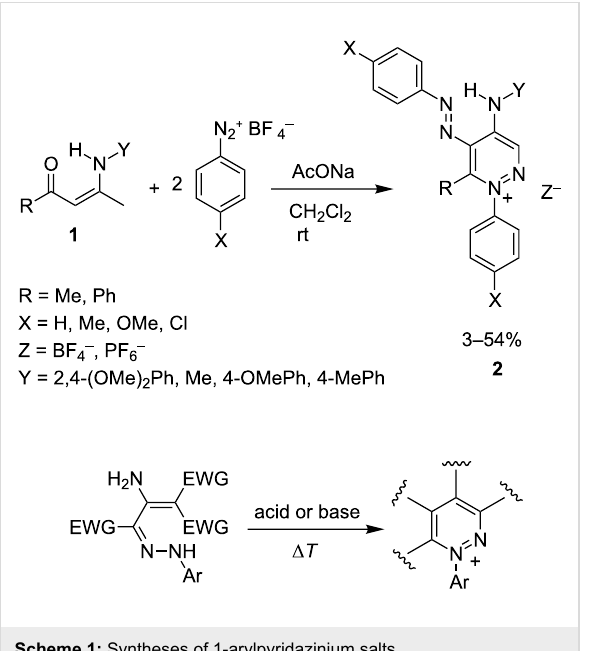
Scheme 1: Syntheses of 1-arylpyridazinium